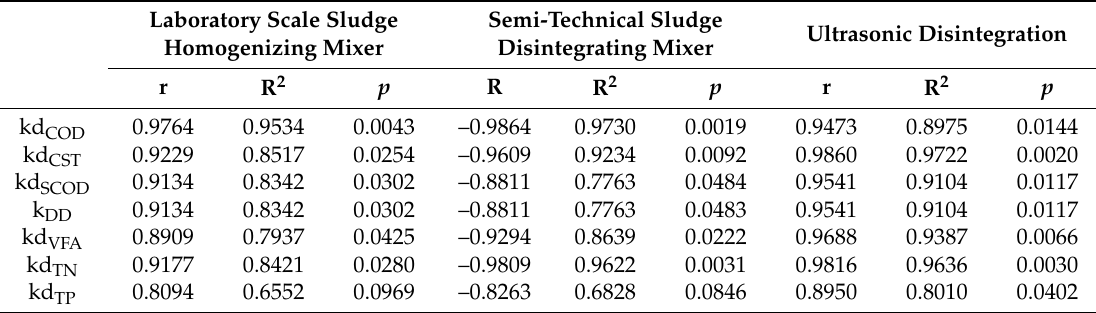
Table 6. The influence of volumetric energy E V on the effects of disintegration monitored as kd indicators; r—correlation coefficient, R 2 —coefficient of determination, p —significance level.